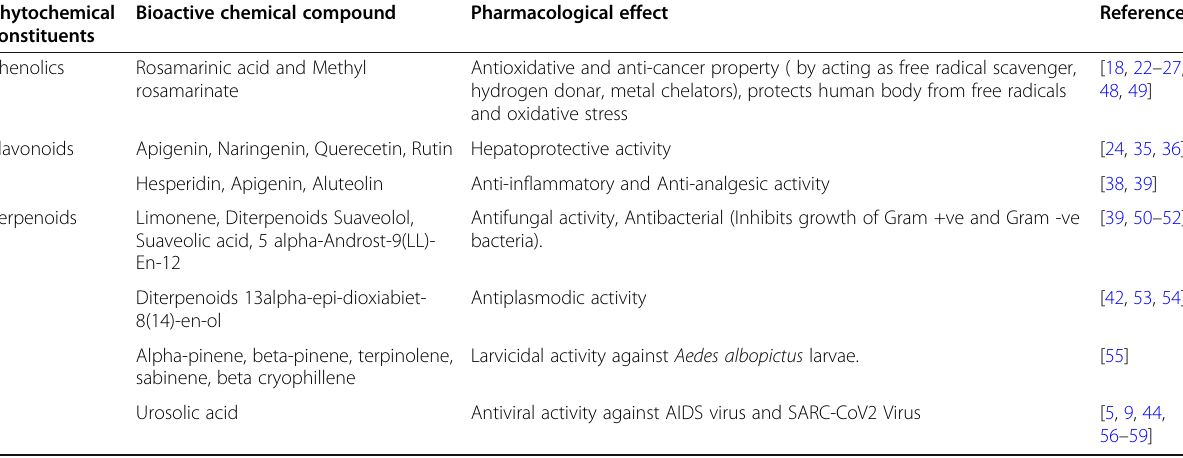
Table 1 Bioactive phytochemicals in Hyptis suaveolens and their pharmacological effects Phytochemical